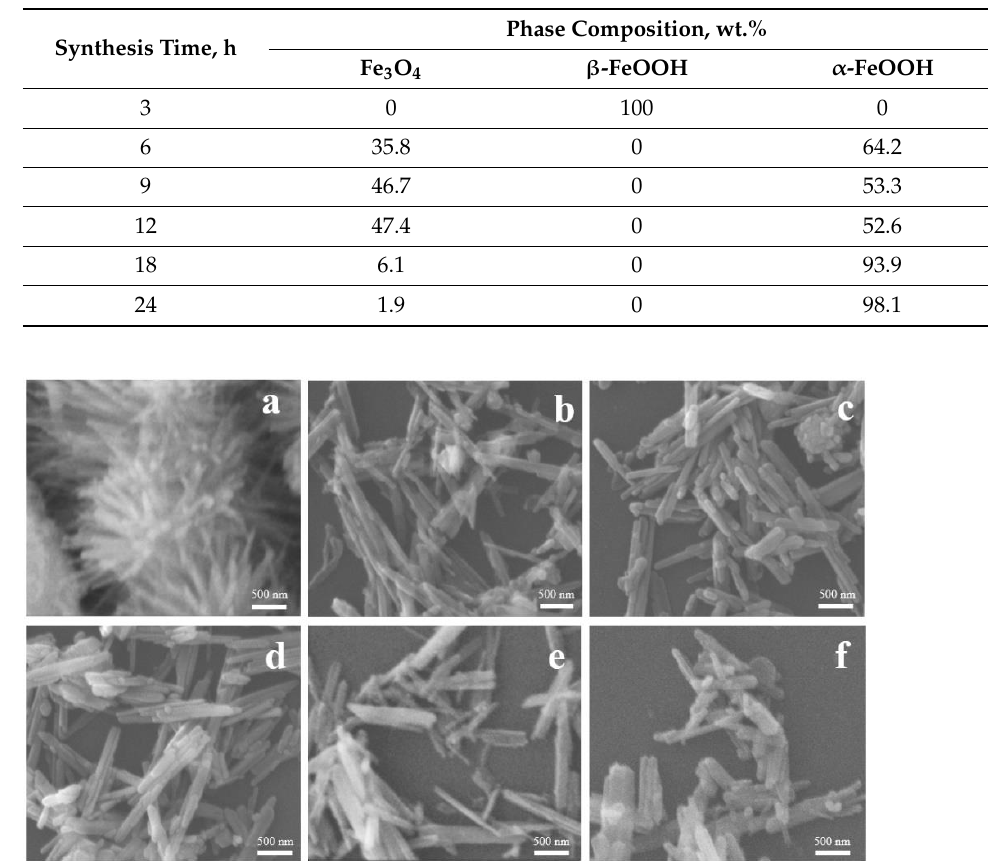
Figure 3. SEM microphotographs of ANPs after 3 ( a ), 6 ( b ), 9 ( c ), 12 ( d ), 18 ( e ), and 24 h ( f ) of syn- thesis.